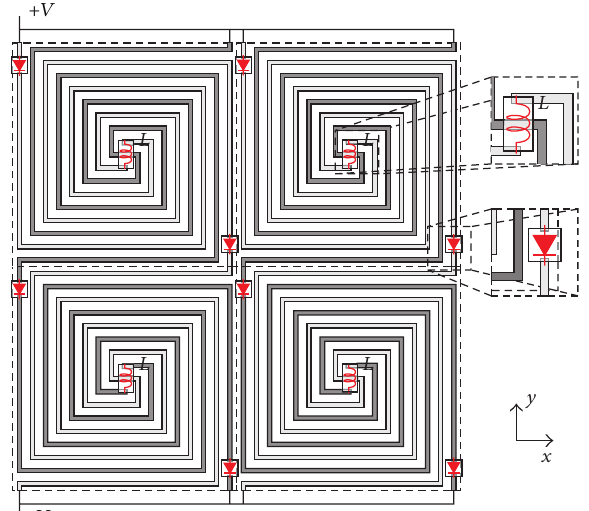
Figure 1: Layout of 2 × 2 array portion of sample free-standing bistate interwoven 9-fold bifilar spiral elements. The reference basic spirals in adjacent unit cells are alternatively marked dark and light grey to highlight the intertwining scheme. Two pin diodes are connected across breaks in the outer folds of the spiral conductors and the choke inductance is placed at the centre of each unit cell between the ends of disconnected spiral arms. Geometrical parameters of the unit cell: lattice period 𝑝 = 10.2 mm, spiral pitch 2.4 mm, and strip width 𝑠 = 0.2 mm and strip thickness 17.5 𝜇